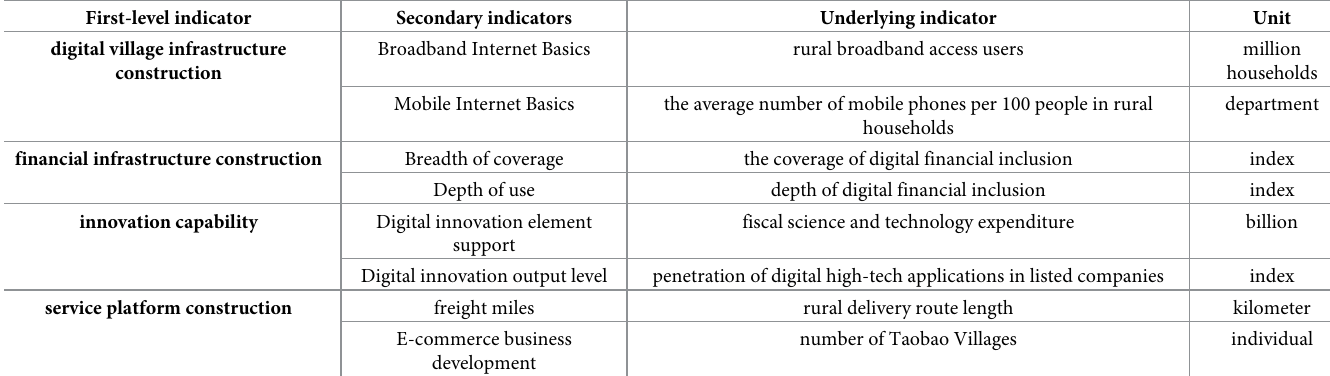
Table 2. Index system of digital rural